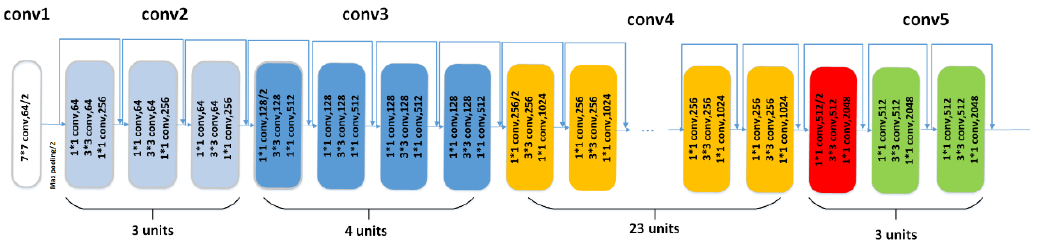
Figure 5. Structure of the Resnet101.